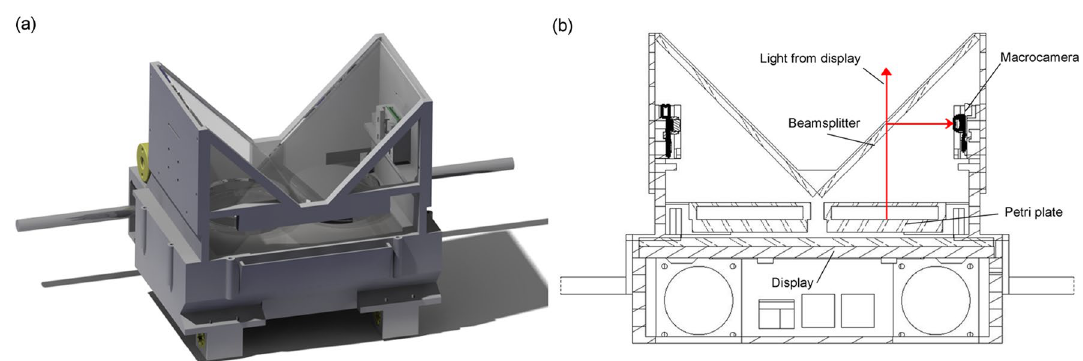
Figure 2. The XY carriage. The image was obtained with SOLIDWORKS 2020 SP3.0. ( a ) The whole carriage, ( b ) a section view to see parts in